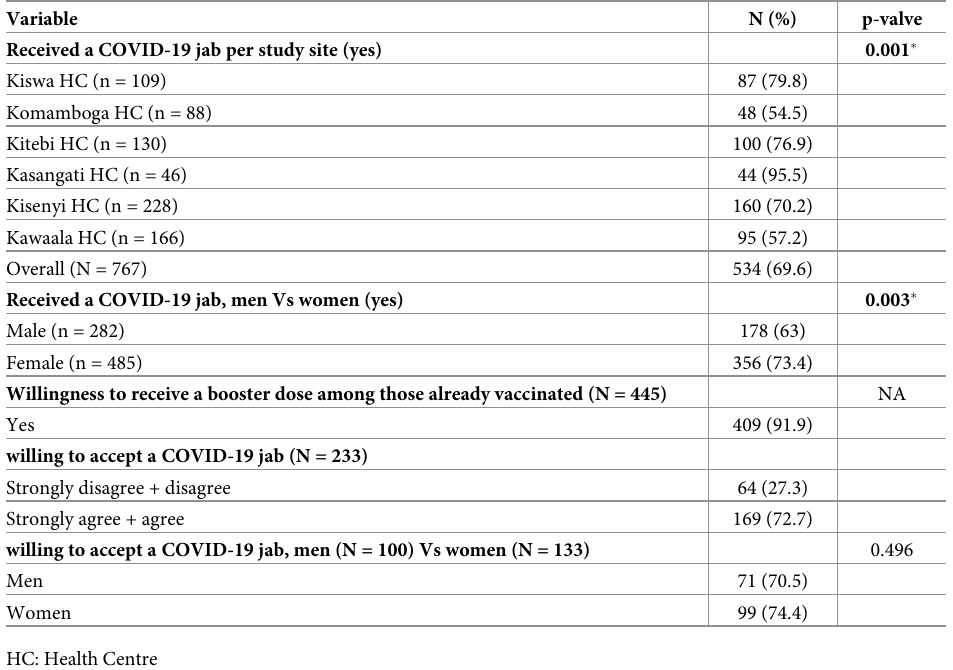
Table 2. COVID-19 vaccination